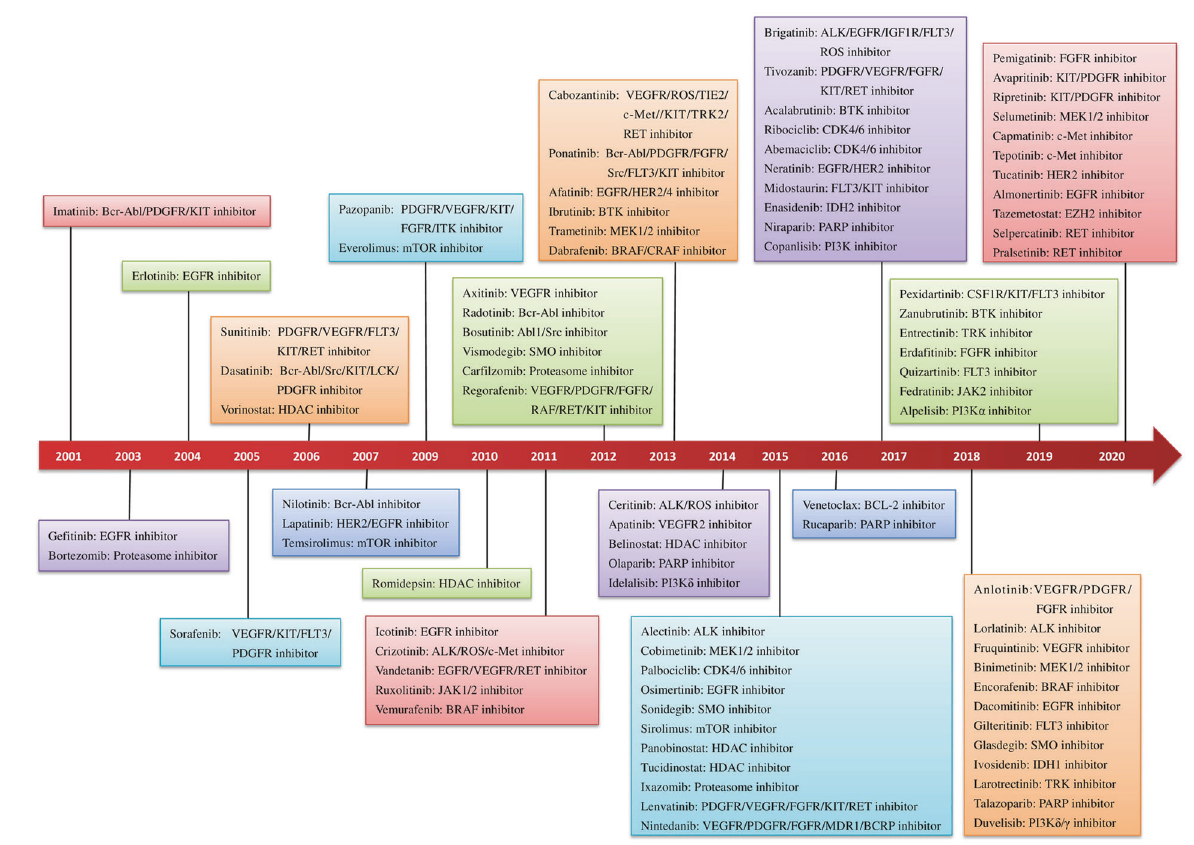
Fig. 1 Timeline for the approval of small-molecule targeted anti-cancer